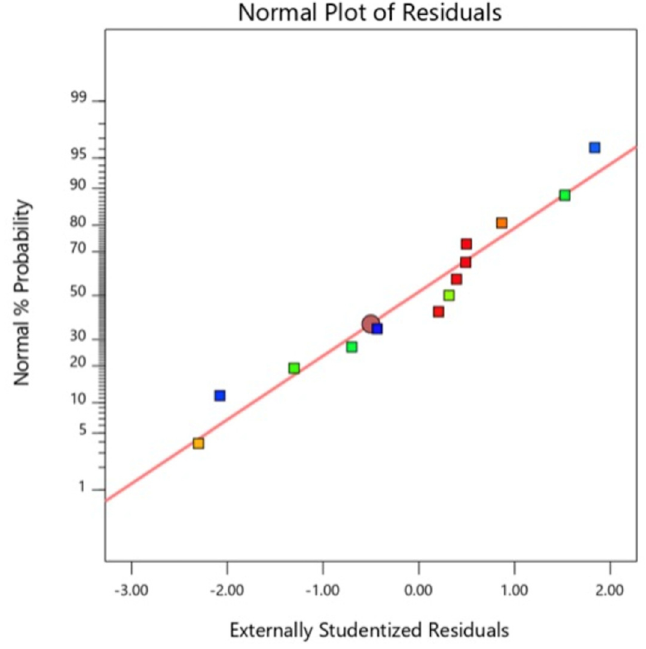
Figure 5. Normal probability plot of ODU sample extracted by UAE method using Central Compos- ite Design.